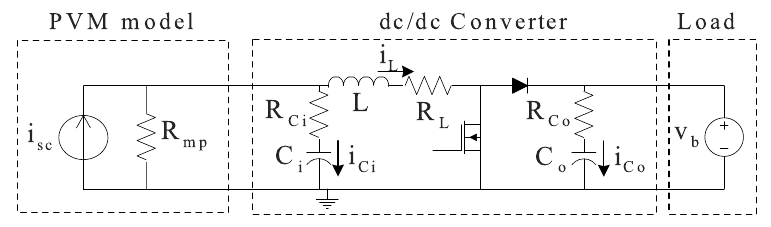
Figure 10. Model considering parasitic losses with voltage-based